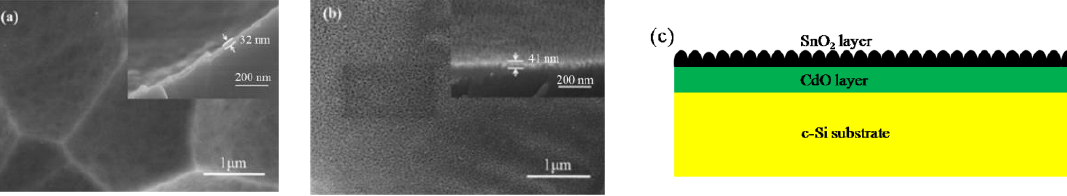
Figure 1. Cross-section and top views of SEM morphologies of ( a ) CdO; and ( b ) SnO 2 films growing on polycrystalline silicon substrates, respectively, and the cross-sectional views are the inset; ( c ) schematic of SnO 2 /CdO/Si DLSC.